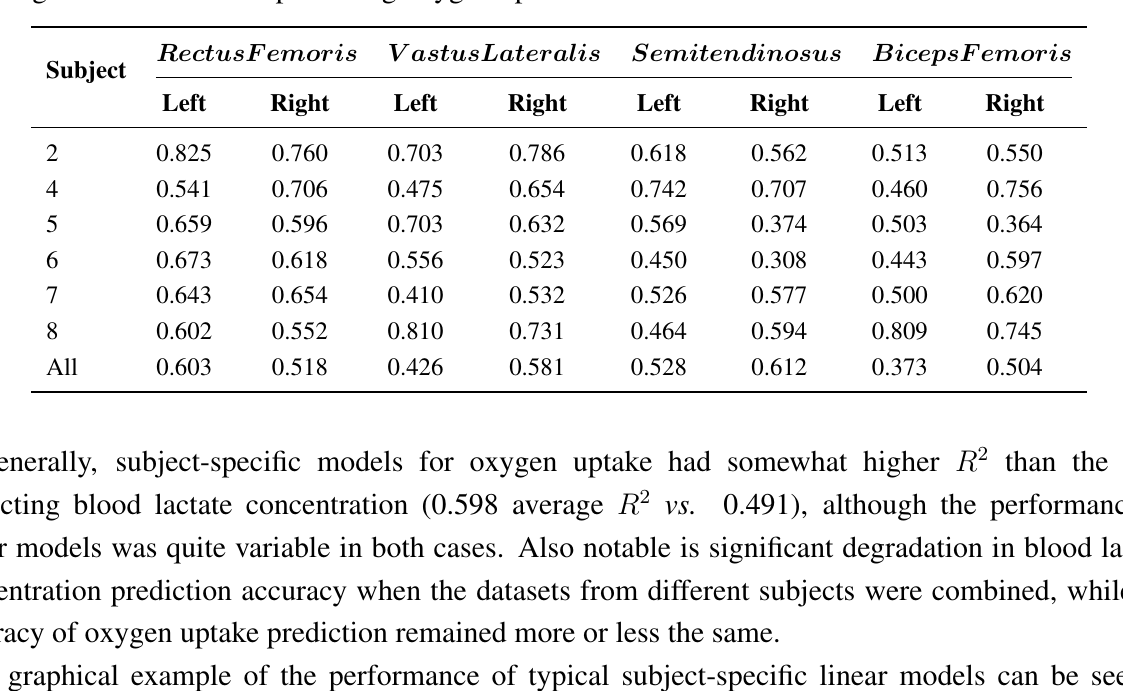
Table 2. The coefficient of determination R 2 for subject-specific, as well as general linear regression models for predicting oxygen uptake.